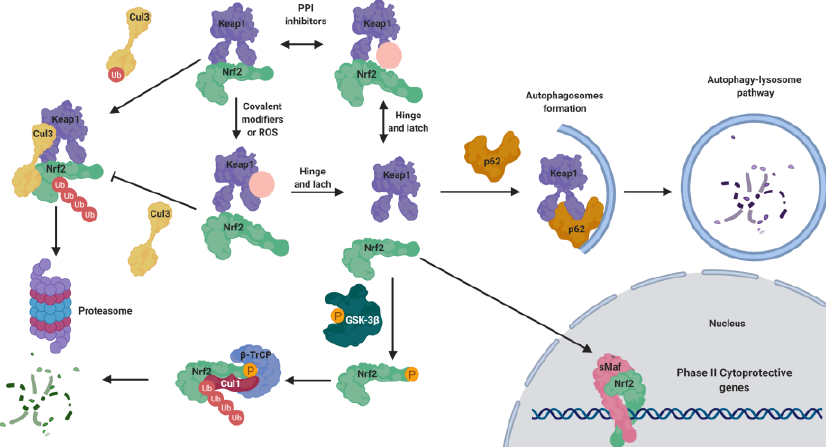
Figure 1. Negative regulation of nuclear factor (erythroid-derived 2)–like 2 (NRF2) under normal conditions and activation under pathological conditions. Under normal conditions, NRF2 is bound to Kelch-like ECH-associated protein 1 (KEAP1), maintaining it in the cytosol. KEAP1 acts as adaptor of the Cullin 3 (CuI3) ubiquitin ligase that ubiquitinates NRF2, leading to its degradation by proteasome 26S. Under pathological conditions, in the presence of reactive oxygen species (ROS) or covalent modifiers, the KEAP1 structure is modified, liberating NRF2 in the cytosol; thereafter, it translocates to the nucleus where it forms heterodimers with small masculoaponeurotic fibrosarcoma (sMaf) proteins to bind the antioxidant response element (ARE) sequences, promoting the expression of phase II genes. This mechanism is known as the “hinge and latch” NRF2 activation mechanism. Moreover, NRF2 is tightly regulated by additional mechanisms. It can be over-activated by the action of p62, since it can induce KEAP1 degradation by the autophagy lysosome pathway. In the opposite, under pathological conditions, in which the kinase glycogen synthase kinase-3 β (GSK-3 β ) is over-active, it can directly phosphorylate NRF2, facilitating its interaction with the Cul1 ligase adaptor β -transducing repeat-containing protein ( β -TrCp) to induce its degradation.